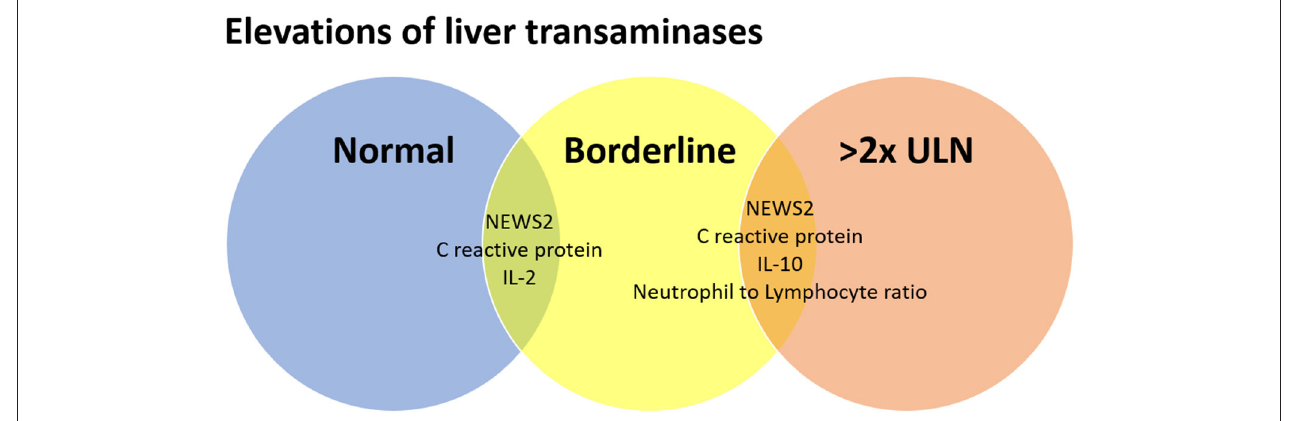
FIGURE 1 | Relationship between the elevations of liver transaminases and inflammatory markers in adult patients with COVID-19. associated with elevations exceeding the ULN range but less than two-fold the ULN, while Neutrophil to Lymphocyte ratio and IL-10 were associated with an increase of at least two-fold the